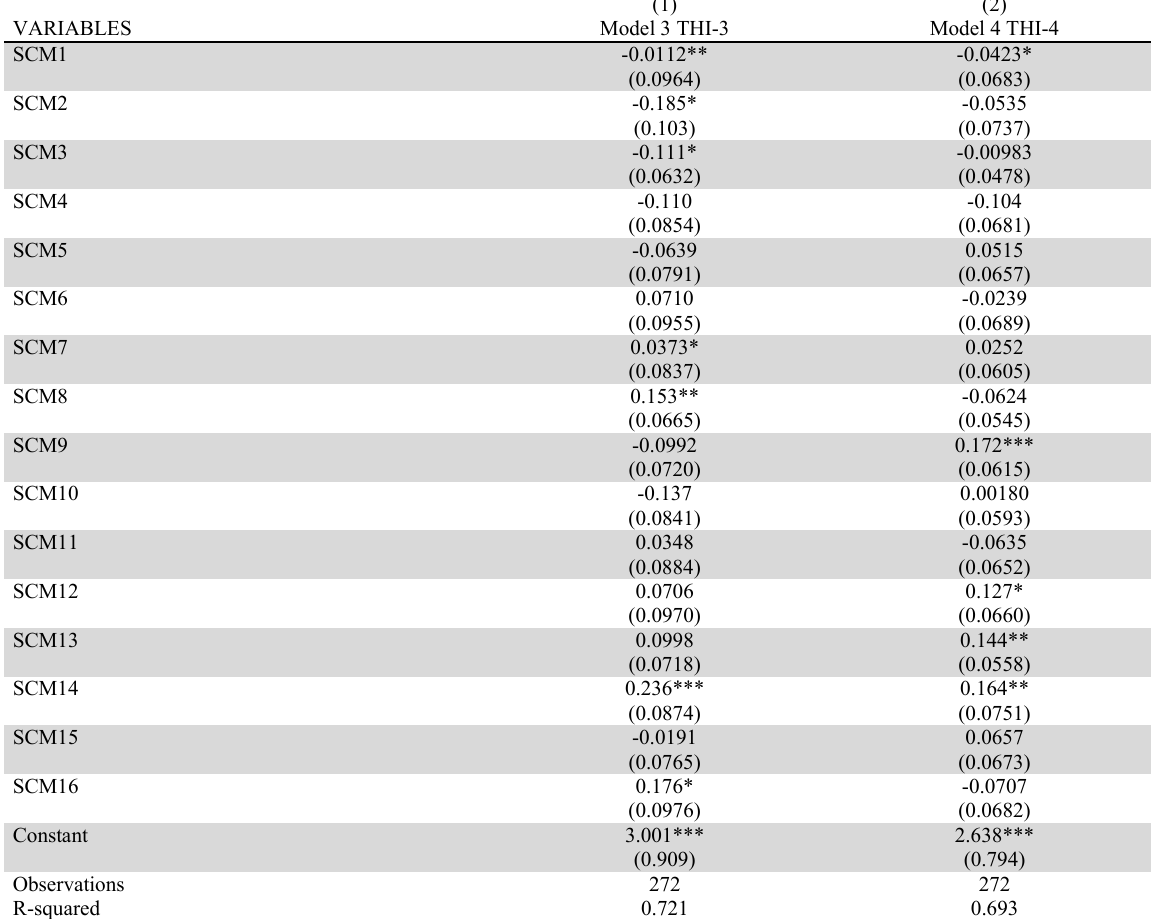
Regression Coefficients and Standard error for Model 3 and Model 4